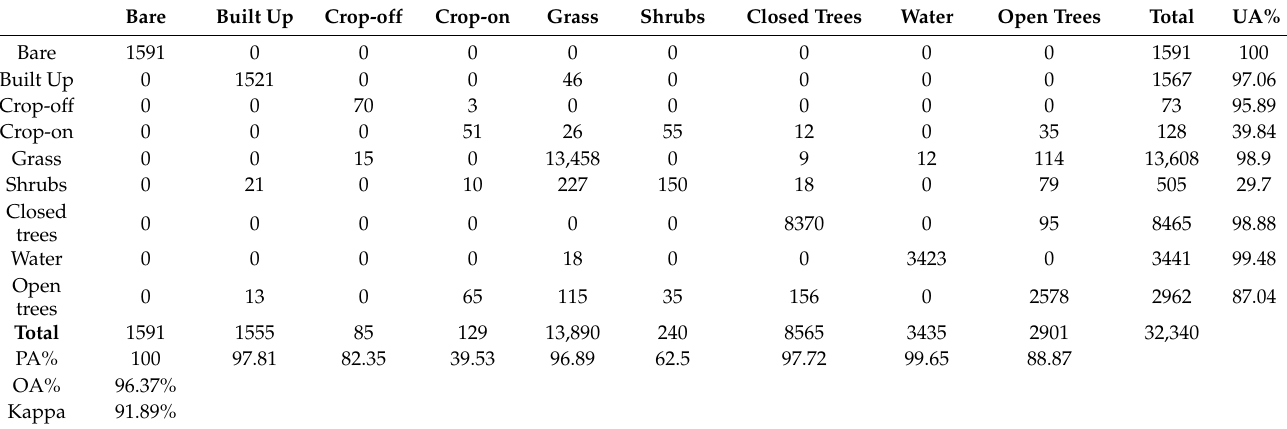
Table 4. Confusion classification matrix for the landscape classes in the Northern Kenya/Southern Ethiopia study region mapped using the Landsat 8 OLI composite images for 2020, and using random forest as a